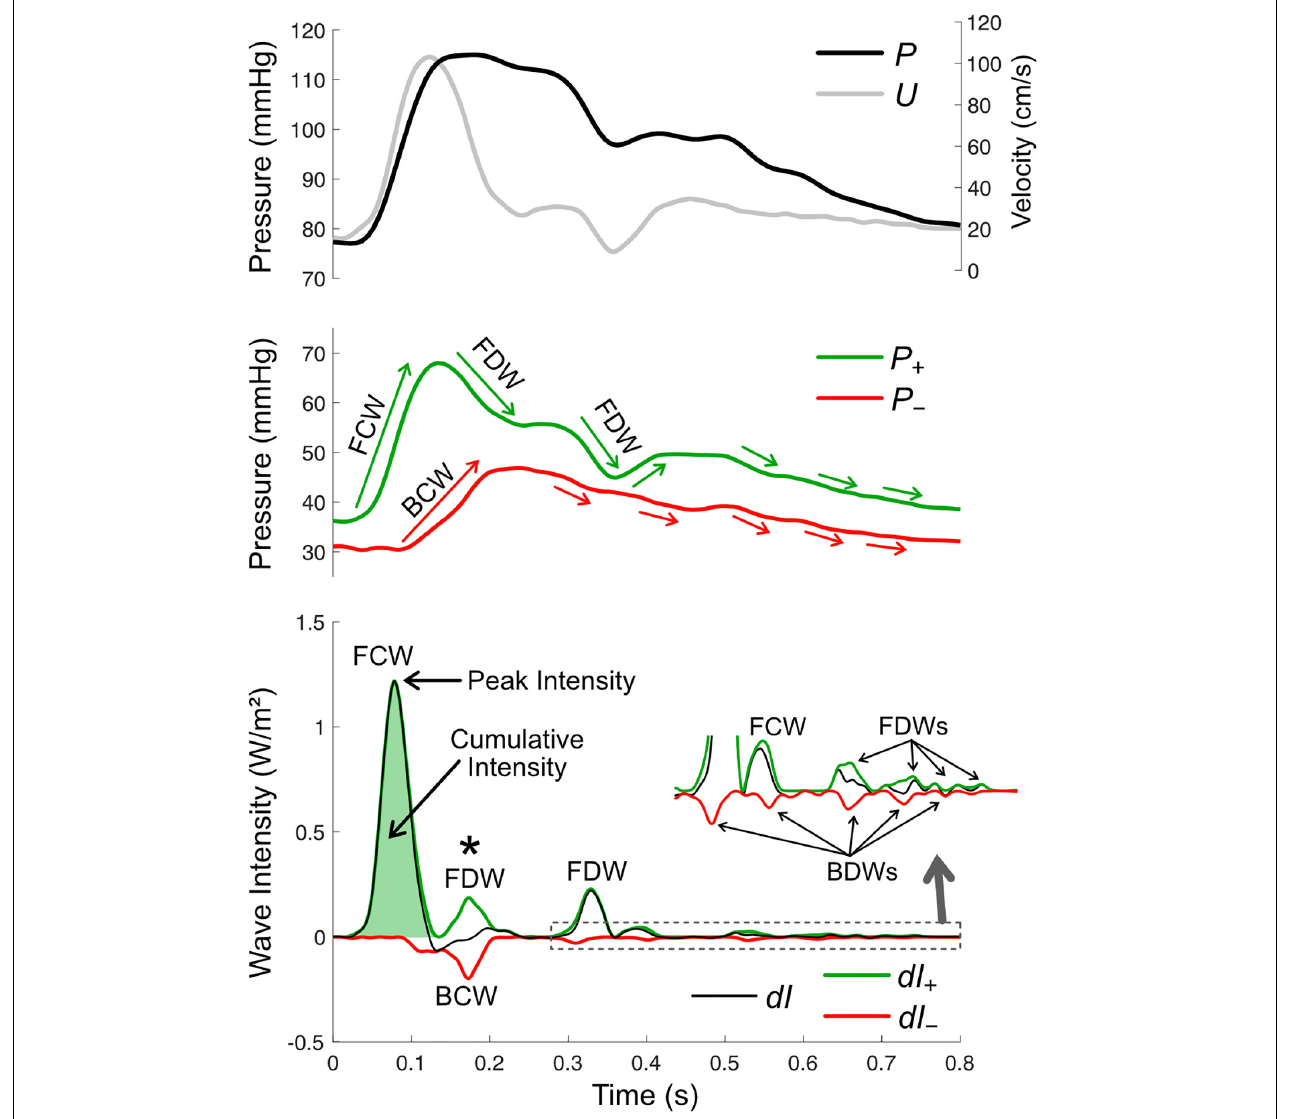
FIGURE 6 | Wave intensity analysis in the carotid artery, based on pressure ( P , derived from measured diameter), mean velocity ( U ), forward and backward components of pressure ( P + and P − ), net wave intensity ( dI ) and forward and backward wave intensity components ( dI + and dI − ). There are four possible wave types, forward compression waves (FCW), forward decompression wave (FDW), backward compression wave (BCW), and backward decompression wave (BDW). Wave size is quantified via peak or cumulative intensity. Whether a wave is a compression or decompression wave can be judged by its effect on the respective pressure components (green and red arrows in the middle panel; note that waves shown in the zoomed inset in the bottom panel are not labeled in the middle panel). The asterisk (*) indicates a time where a BCW and FDW arrive at the measurement site around the same time and therefore wave separation is essential for revealing the presence/magnitude of these